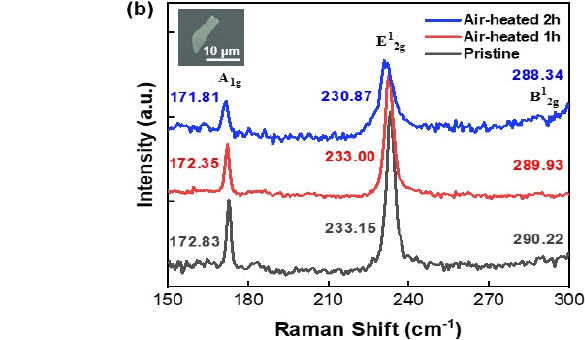
Figure 3. Raman spectra of ( a ) MoTe 2 in air exposure and ( b ) MoTe 2 under air heating. Device #2 with a channel height of 6 nm also demonstrated a similar doping effect;